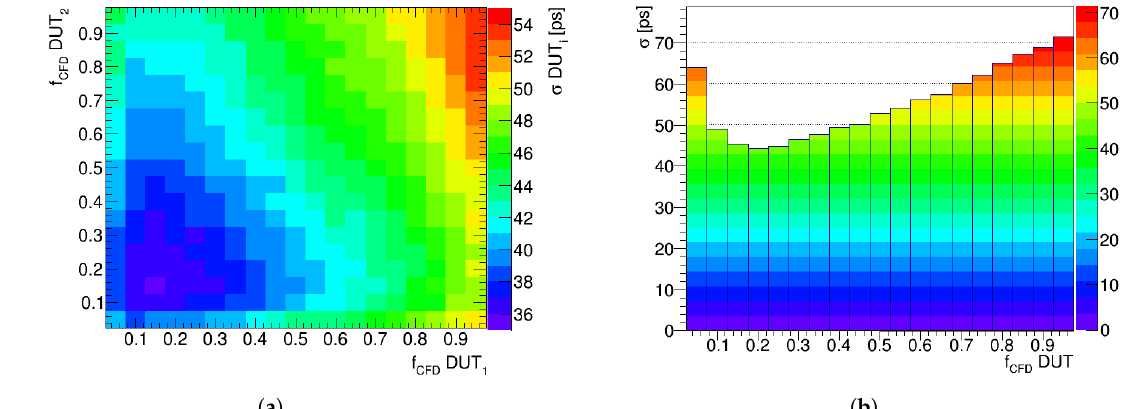
Figure 13. ( a ) Two-dimensional map of time resolution as a function of CFD fractions for unirra- diated boron CNM LGADs. ( b ) Time resolution as a function of a CFD fraction for a DUT sensor (unirradiated gallium).